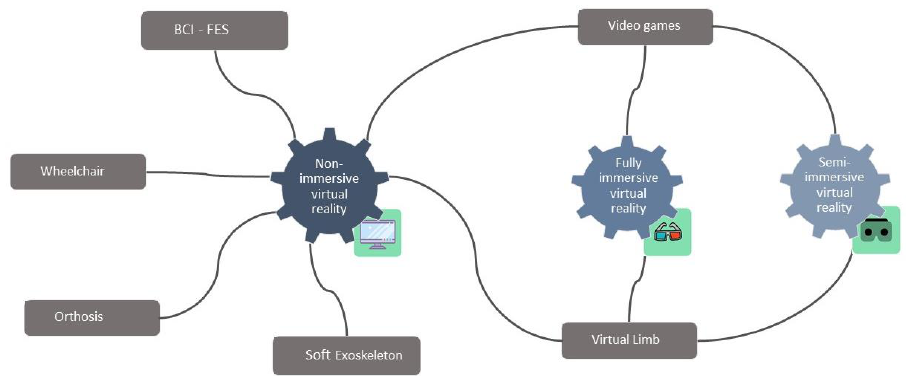
Figure 3. Interconnection between the type of BCI application and the type of virtual reality em- ployed.